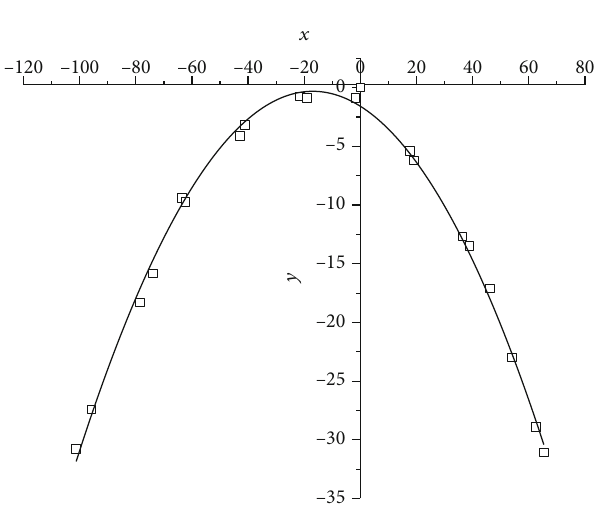
Figure 6: Fitting the equation image according to Figure